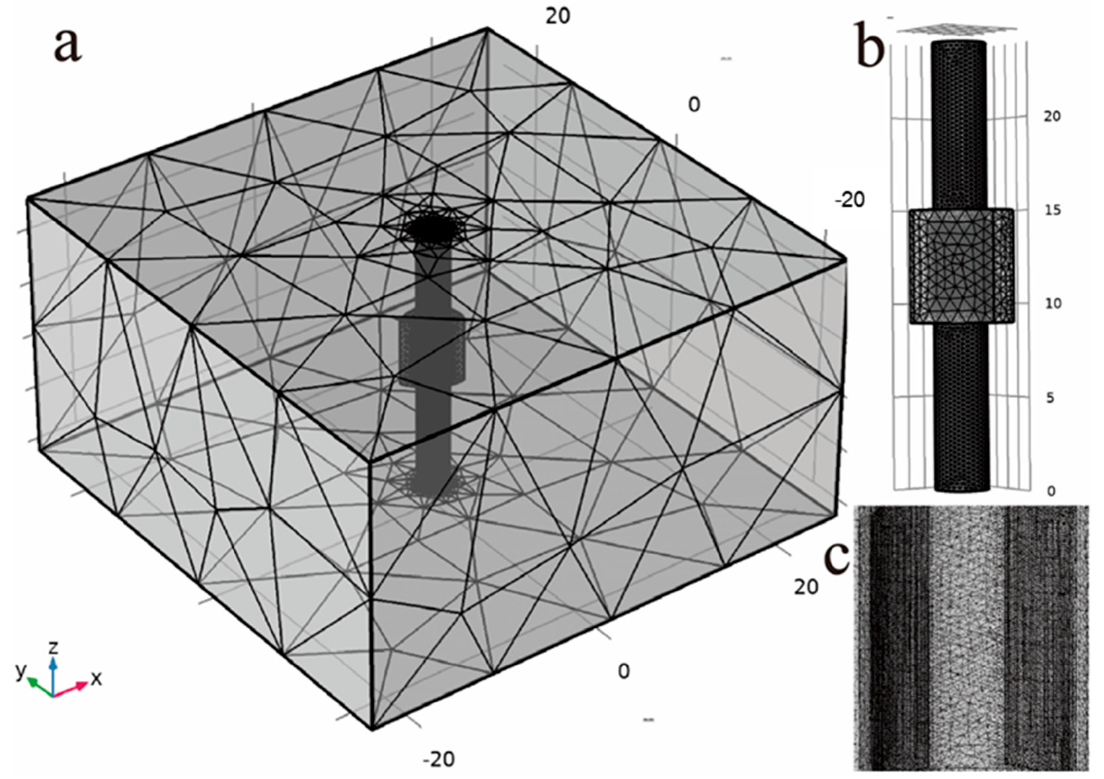
Figure A4. ( a ) A picture of the meshed model. ( b ) Domains with refined mesh included the catheter and electrodes as well as the target arterial tissues close to the electrodes. ( c ) A magnified view of the paired electrodes in ( a ).